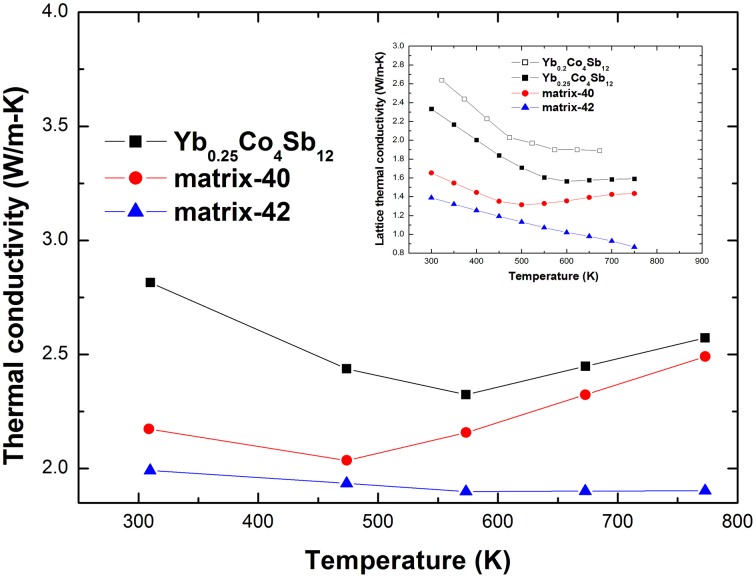
High temperature thermal conductivity and lattice thermal conductivity of the studied materials, the lattice thermal conductivity of Yb0.2Co4Sb12 from literature (Fu et al., 2013) is present for comparison.